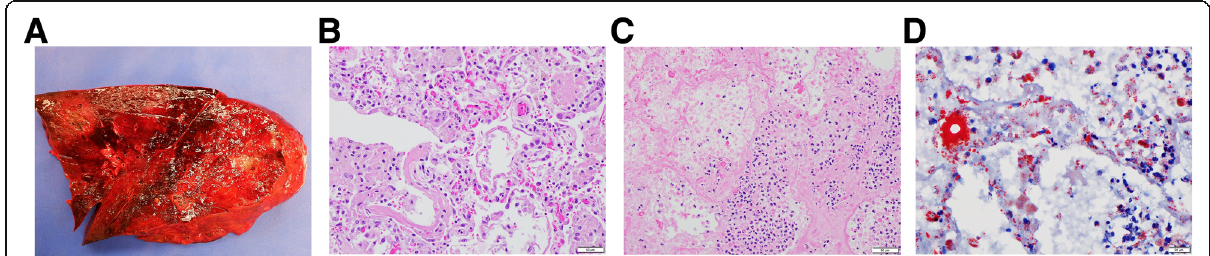
Fig. 4 a Gross photo of a cut surface of lung, which shows solid, hemorrhagic areas with necrosis. b Microscopic photo of diffuse alveolar damage (DAD) in the exudative phase, with hyaline membrane formation, fibrinous and cellular exudate in alveolar spaces. c Large area of necrotizing bacterial pneumonia. d Special stain Oil Red O, demonstrating lipid containing macrophages in alveolar spaces and alveolar